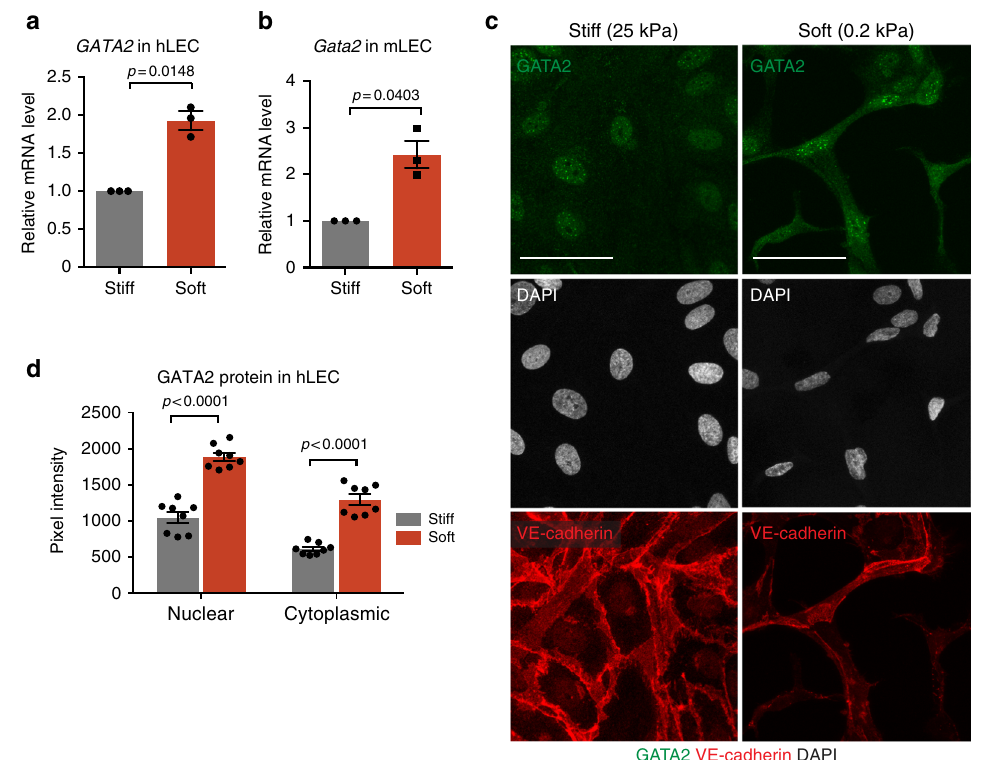
Fig. 2 GATA2 regulation by matrix stiffness in LECs. a , b qRT-PCR analysis of GATA2 in human LECs ( a ) and primary mouse LECs ( b ) grown on soft (0.2 kPa) or stiff (25 kPa) matrix. n = 3 experiments, mean ± s.e.m. p value, one-sample t -test. c Immuno fl uorescence of human LECs grown on stiff and soft matrix using antibodies against GATA2 (green) and VE-cadherin (red), and for DAPI to show nuclei (grey). LECs grown on soft matrix exhibit an overall higher expression of GATA2 as indicated by higher immuno fl uorescence intensity in both the nucleus and cytoplasm and have an elongated shape and a distorted nucleus. d Quanti fi cation of nuclear and cytoplasmic GATA2 protein in human LECs grown on soft (0.2 kPa) or stiff (25 kPa) matrix. Data represent mean pixel intensity ( n = 8 images with 8 – 24 cells per image (soft), and n = 8 images with 21 – 37 cells per image (stiff) from 3 experiments) ± s. e.m. p value, unpaired Student ’ s t -test. Scale bars: 50 µ